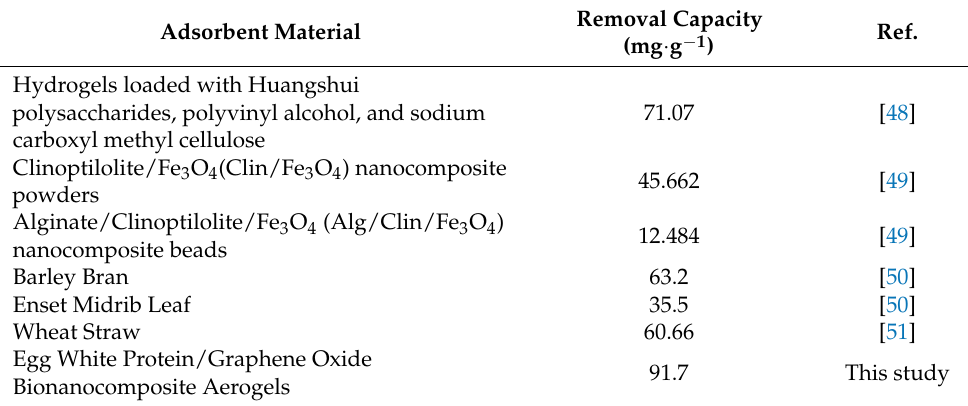
Table 4. Comparison of maximum removal capacities of different adsorbent materials for MB. Removal Adsorbent Material